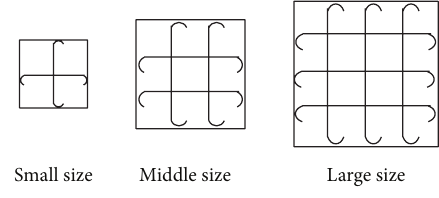
Figure 10: Configurations of